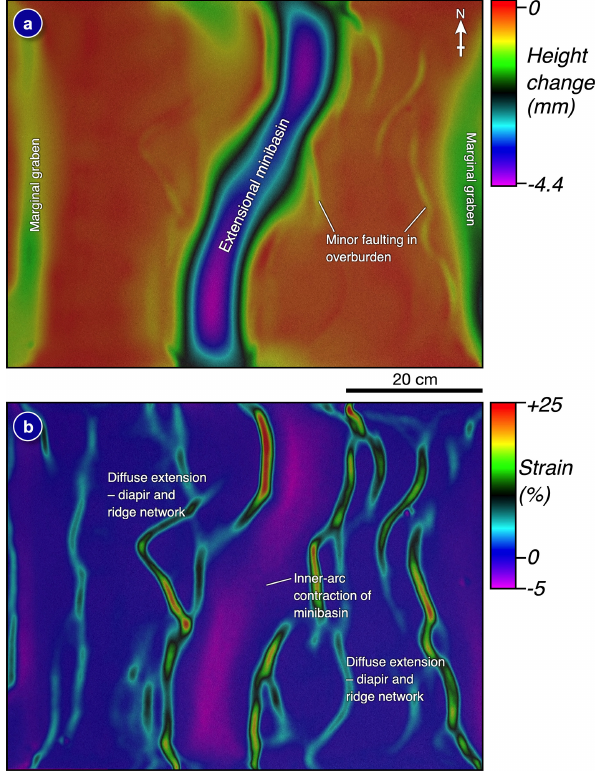
Figure 5. (a) Height-change map during post-salt extension in Model 1. Post-salt extension was now 4cm. Note the composite minibasin extending across the model center, which is above the original graben system. (b) Strain map of the same increment of post-salt extension. Note the diffuse strains in the suprasalt cover. Most extensional strains mark outer-arc extension above reactive diapirs. Note the minor shortening strains within the minibasin due to inner-arc contraction within the subsiding minibasin.